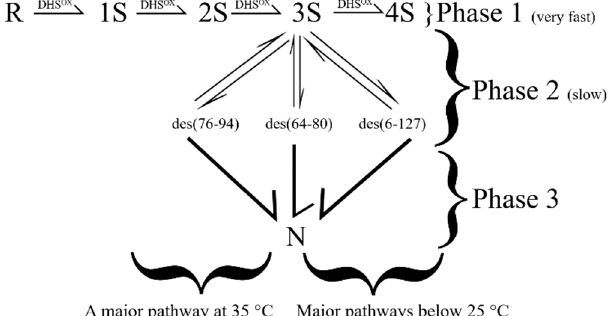
Figure 3. The oxidative folding pathway of HEWL. In Phase I, unstructured intermediates are rapidly formed. Structure is acquired in phase 2 via the concomitant oxidation and conformational folding of native-disulfide-bond-containing 2S species to form three 3S* intermediates. N HEWL is formed from the oxidation of all three 3S* species, albeit with differences in flux.